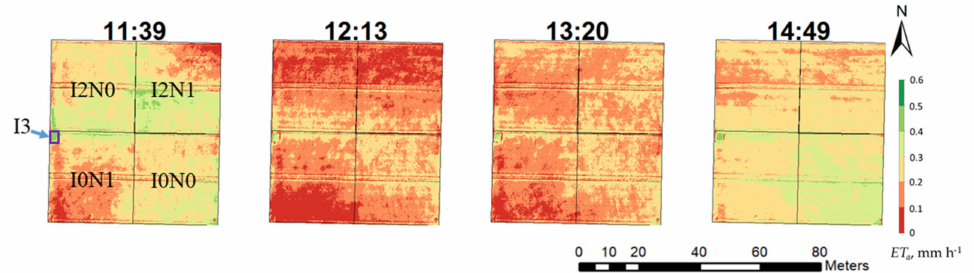
Figure 10. Diurnal spatiotemporal distribution of actual evapotranspiration ( ETa ) of winter wheat on 28 June 2019 in Denmark. I0, I1 and I2 are minimum, optimum and full irrigation, respectively. N0 and N1 are without and with additional fertilization. I3 is a small plot (3 × 2 m) additionally irrigated the day prior the flight on 28 June